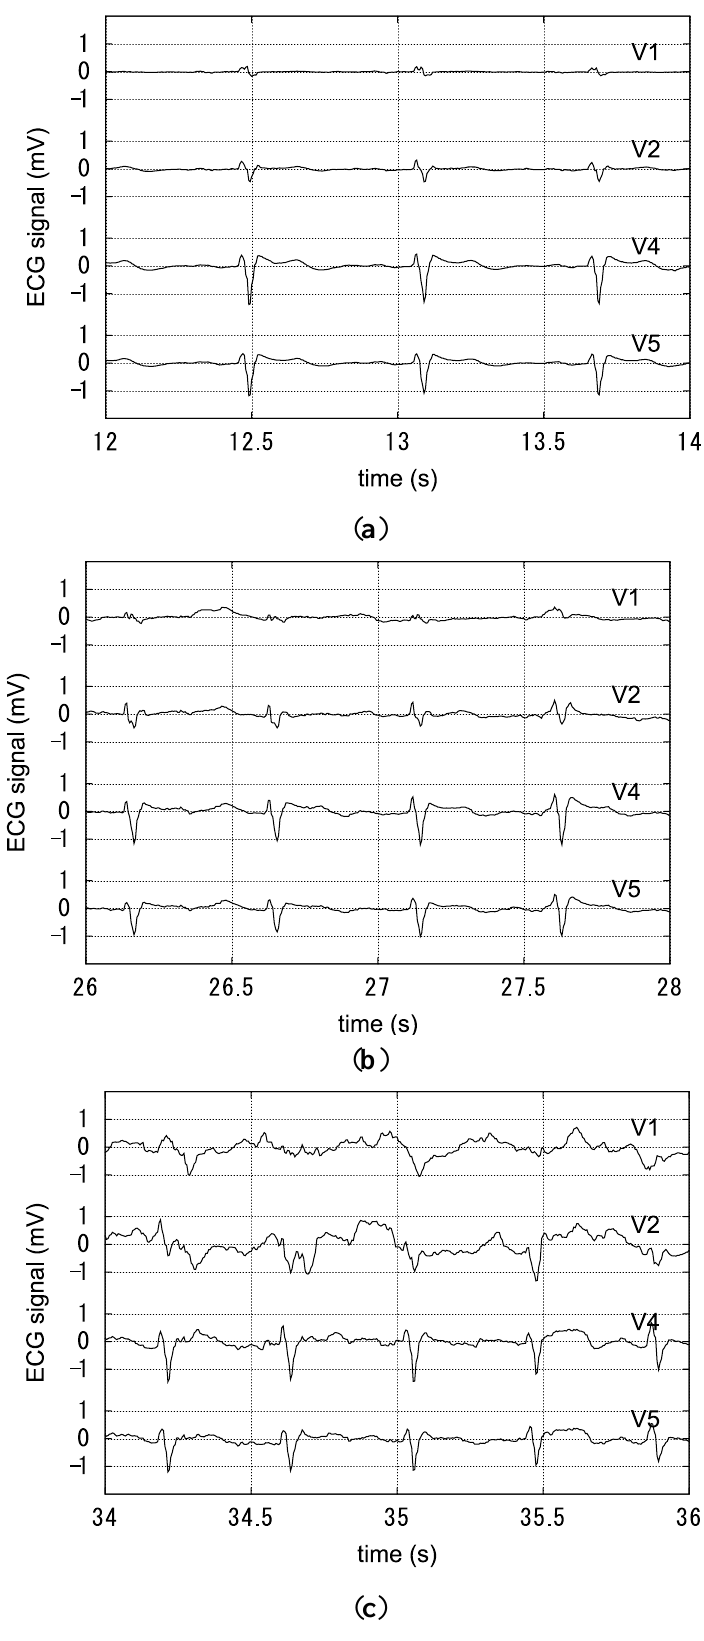
Figure 11. ECG signals measured by the smart shirt with the conductive foam blocks: ( a ) the subject resting in a chair; ( b ) the subject walking; ( c ) the subject slowly